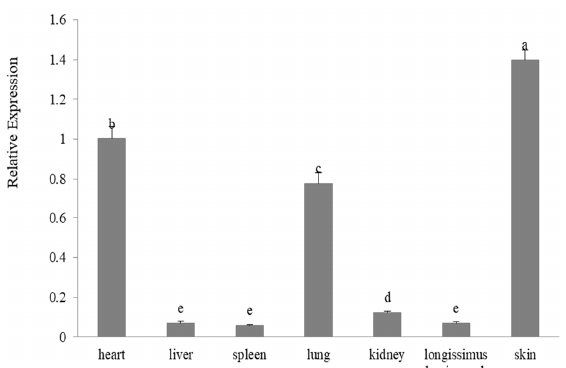
Figure 8. The relative expression levels of the ovine keratin-associated protein 2-1 gene in the seven tissues obtained from Gansu Alpine Fine-wool sheep. Different lowercase letters above the bars indicate that significant differences ( p < 0.05) in expression of keratin-associated protein 2-1 gene exist between tissues, with, for example, skin having a significant difference in keratin-associated protein 2-1 gene expression relative to all the other tissues studied.